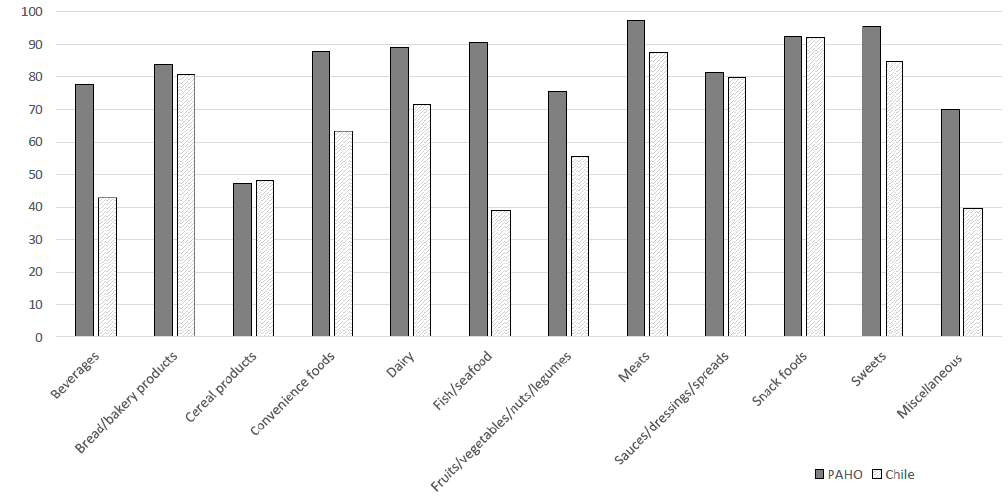
Figure 1. Proportion of packaged food and beverage products meeting the criteria for regulation under PAHO and Chilean nutrient profile models.